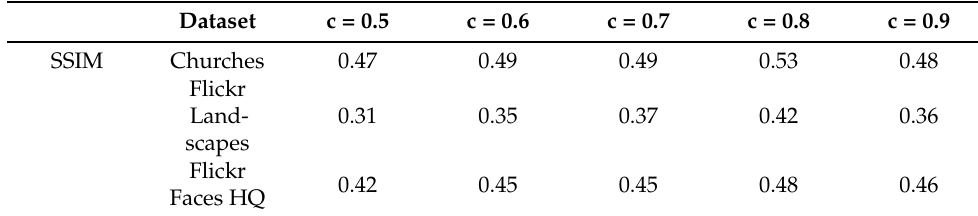
Figure 6. Landscape style transfer results. Table 2. SSIM with different c values.